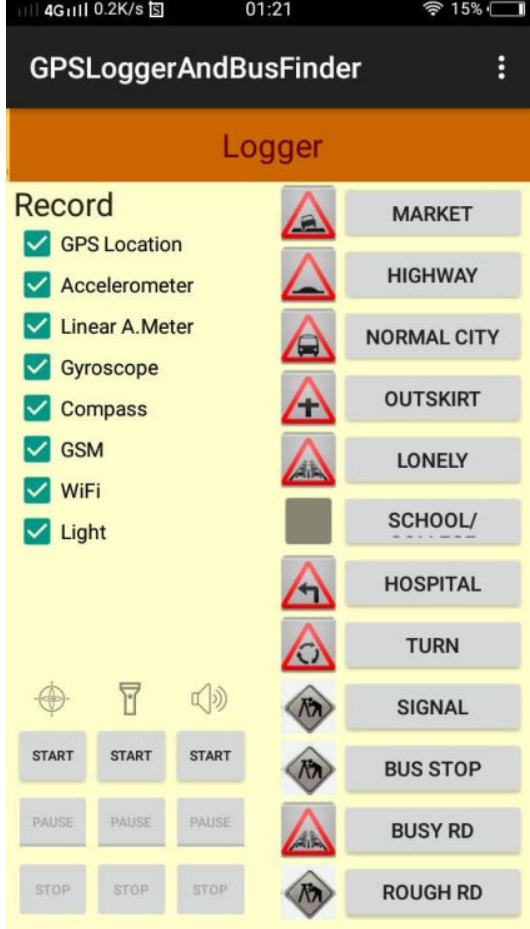
Figure 2. Android Application for Sensor Data